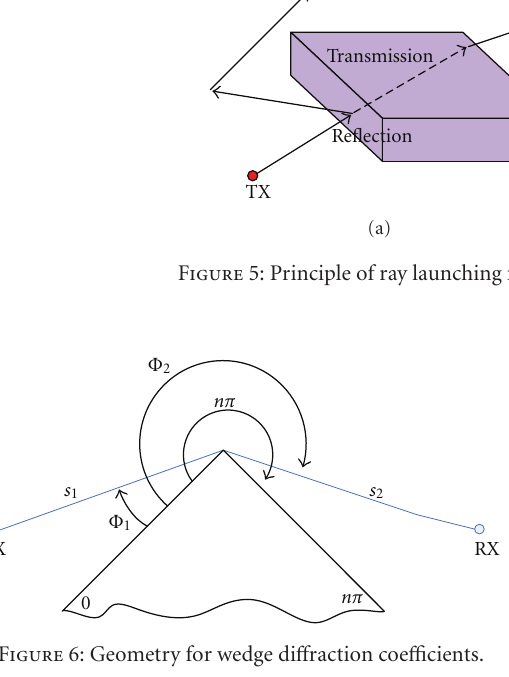
Figures 2(a) and